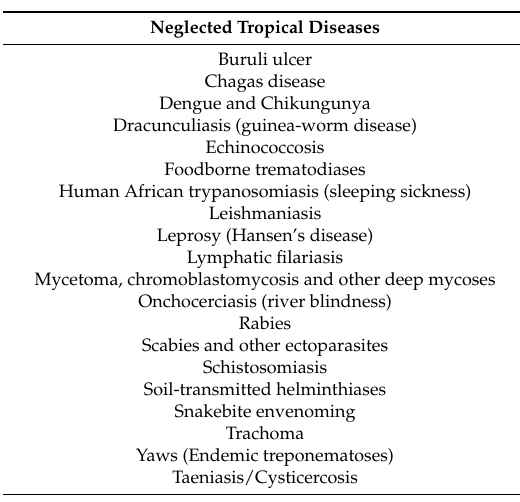
Table 1. Neglected Tropical Diseases